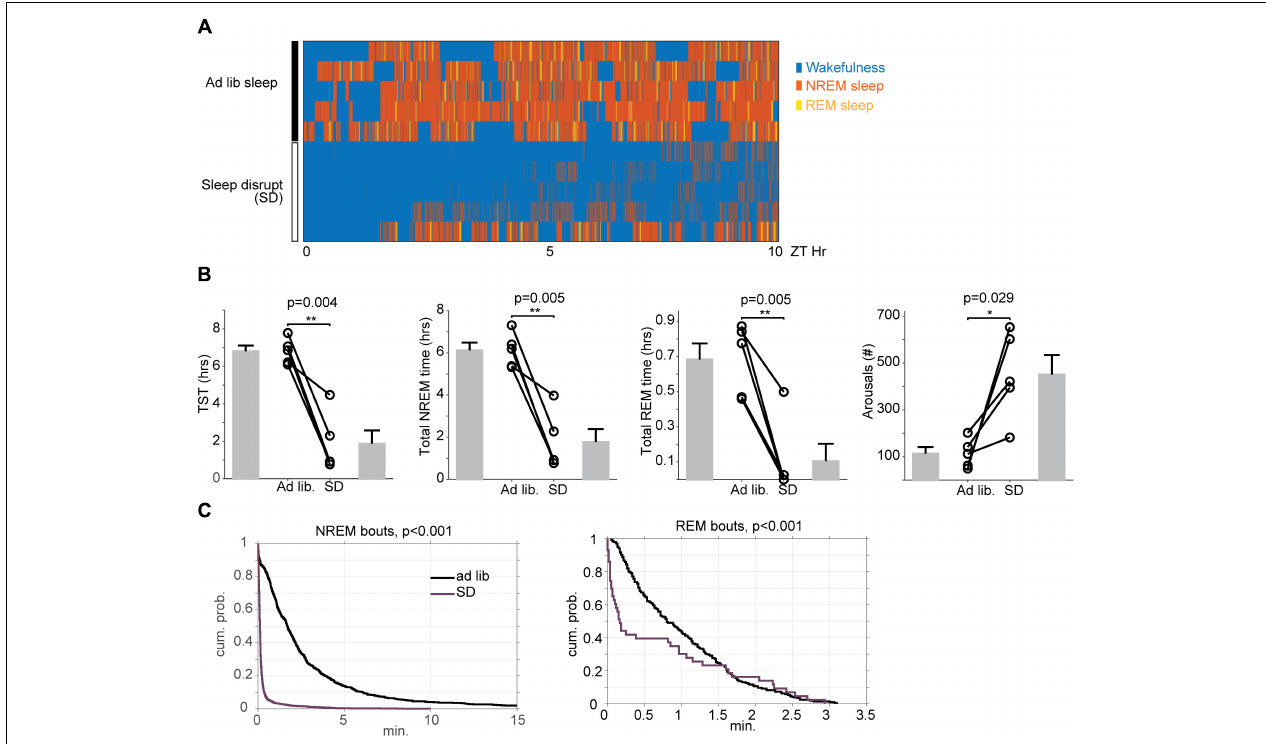
FIGURE 3 | Effects of 10 h of automated sleep disruption on sleep physiology. (A) Hypnograms between ZT0 and ZT10 for five mice during baseline undisrupted sleep (top) and during 10 h of sleep disruption (bottom). (B) Mice undergoing 10 h of sleep disruption show significant decreases in total sleep time, NREM duration, and REM duration, and significant increases in wake duration and number of state transitions. (C) Survival curves (cumulative probability distributions) of NREM and REM runs in the normal baseline sleep and sleep disrupted conditions demonstrate significant fragmentation of all vigilance states. The curves represent the probability ( y -axis) of sleep of that stage lasting the duration shown on the x -axis. Leftward shifted curves reflect higher sleep fragmentation. ∗ p < 0.05, ∗∗ p < 0.01.